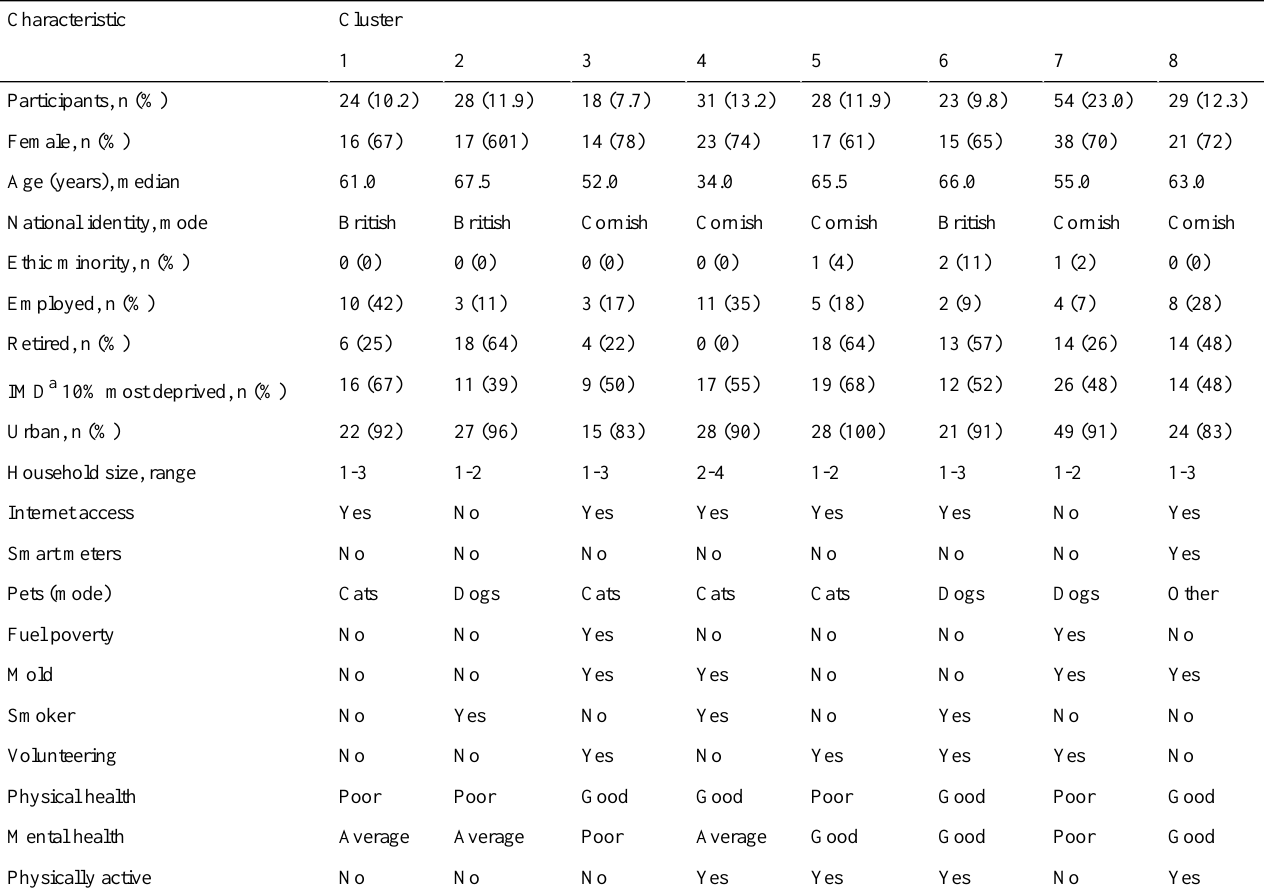
Table 1. Summary characteristics of the 8 clusters identified by the k-prototype analysis of the baseline survey data.